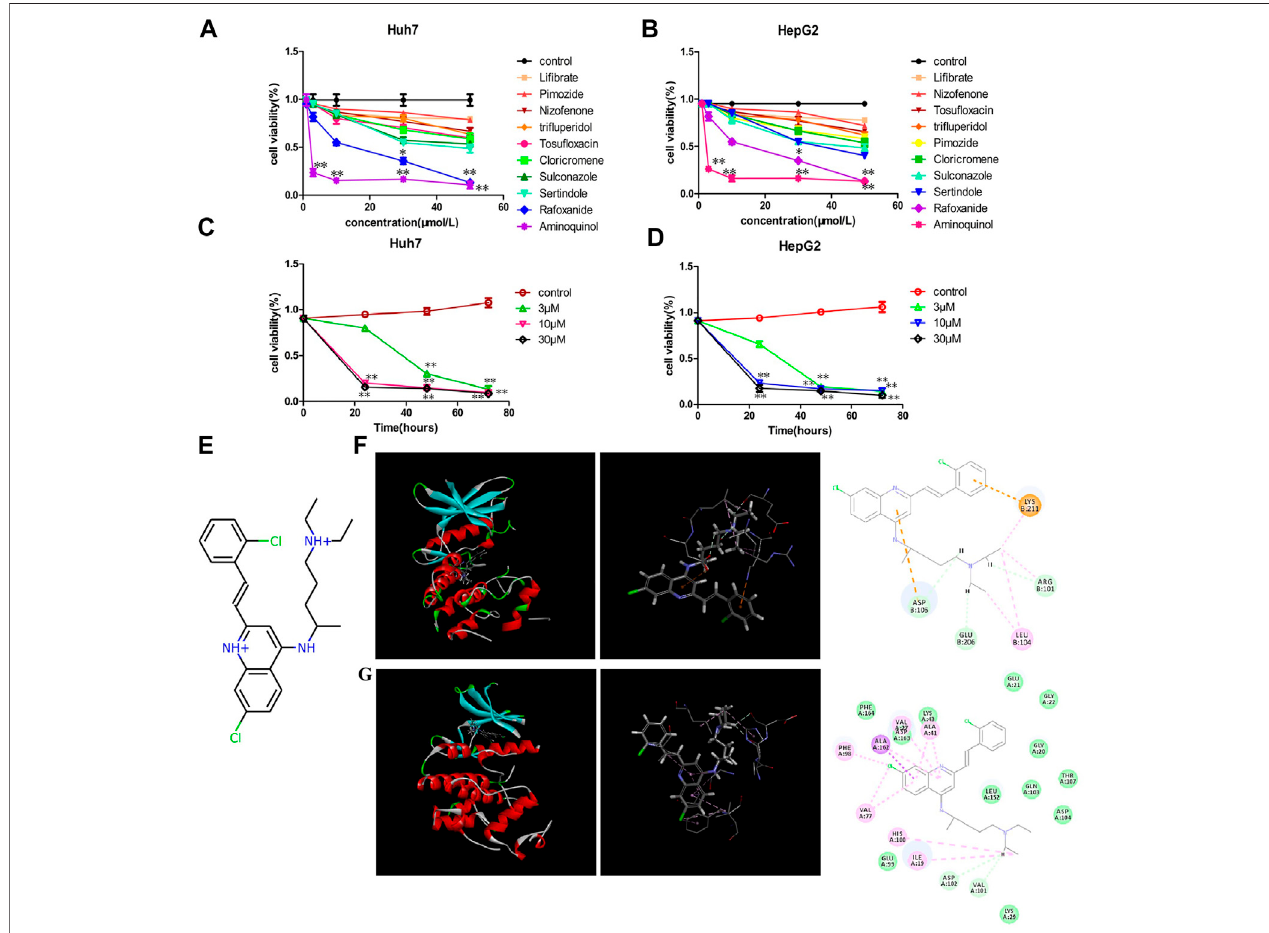
FIGURE 1 | The effect of aminoquinol on the cell viability in human hepatocarcinoma Huh7 and HepG2 cell lines (A) The effect of ten candidate compounds on the cell viabilityinHuh7 cellsand (B) inHepG2cells (C) Time-response curves fordifferentdosesofaminoquinolin Huh7cells and (D) inHepG2 cells (E) The predicted two- dimensional chemical structure of aminoquinol (F) Computer docking analysis of the interaction of aminoquinol with CDK4 and (G) with CDK6 *, ** indicate signi fi cant difference at p < 0.05, p < 0.01, respectively.